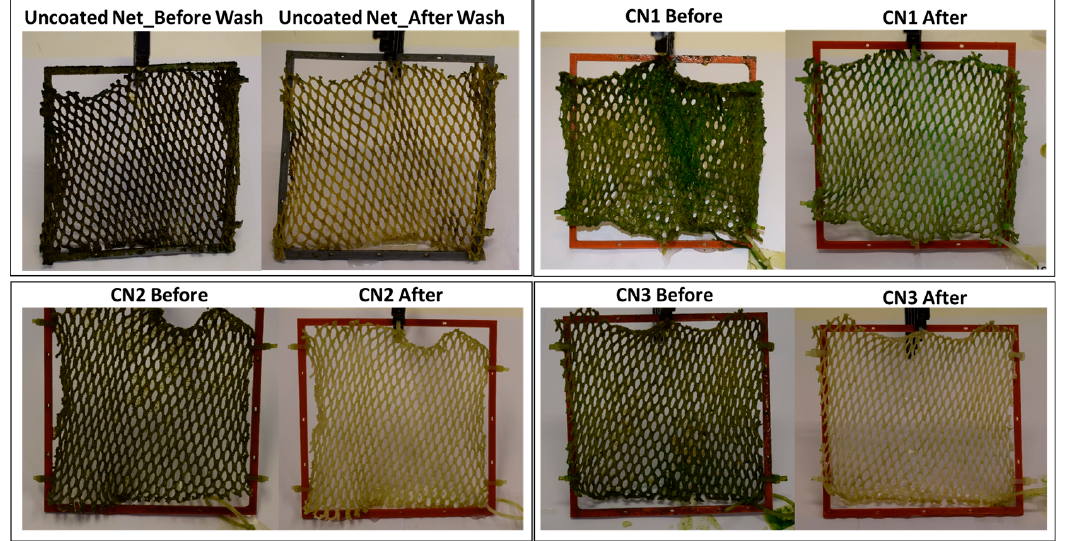
Figure 8. Photographs of the uncoated and coated nets before and after pressure washing with wa ‐ ter, on day 24 of the experiment.